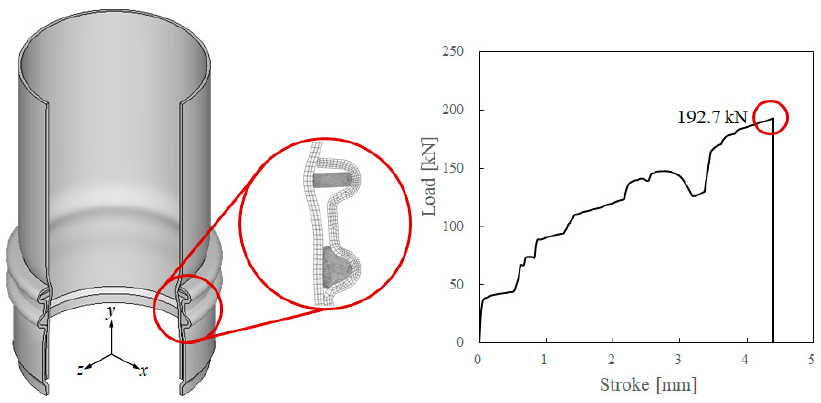
Figure 6. Numerical load–stroke curves of the proposed SR-joint (SR-II).